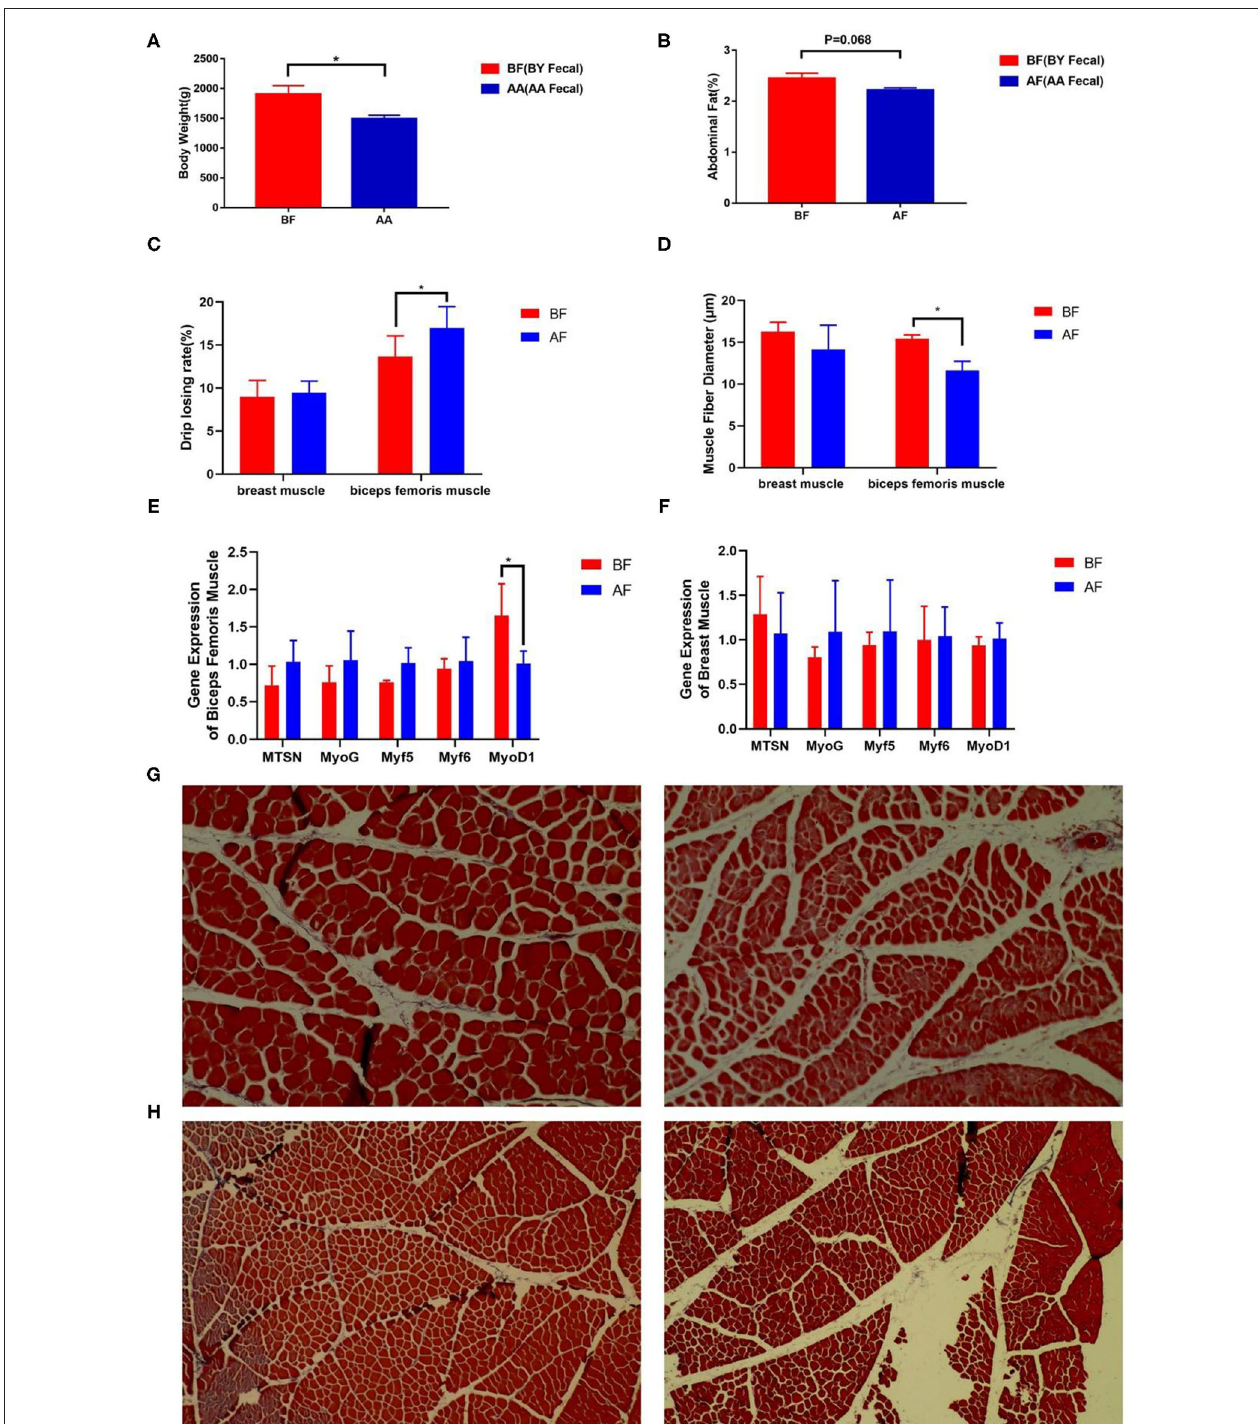
FIGURE 4 | Drip loss and abdominal fat were altered after FMT. (A) Body weight, (B) abdominal fat, (C) drip loss, (D) muscle fiber diameter after FMT, (E,F) relative expression of muscle fiber diameter-related genes, (G,H) paraffin sections of muscle fiber (BF: left and AF: right) [ (G) biceps femoris muscle fiber and (H) breast muscle fiber]. AF: Fecal transfer from the Arbor Acres broilers into the Arbor Acres broiler; BF: Fecal transfer from the Beijing-You broilers into the Arbor Acres broilers. The numbers of independent biological samples analyzed in panel A to H were AF ( n = 5) and BF ( n = 5). All the data are expressed as mean ± SEM. All the data were analyzed using ANOVA, followed by the Tukey’s test, and were considered as statistically significant at * p < 0.05 between the indicated groups. Figures in (G,H) are muscle fiber of HandE staining.